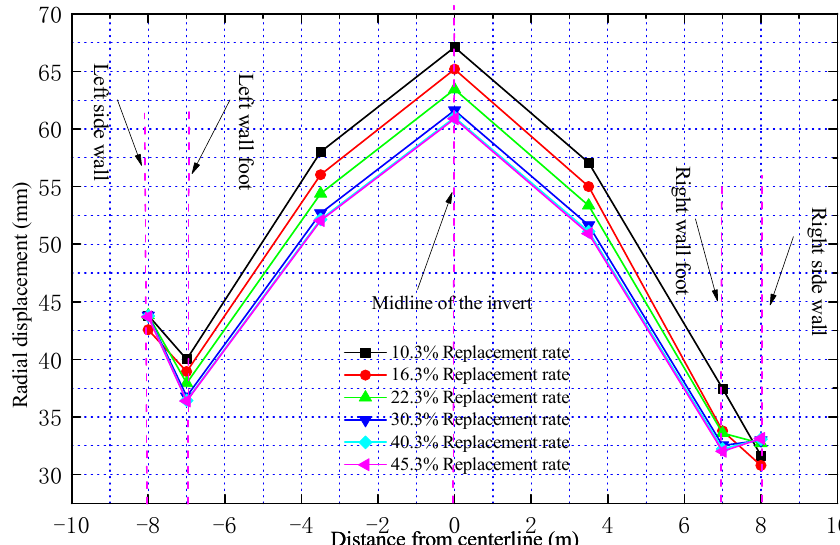
Figure 8. Soil displacement of base and side wall (different replacement rates).